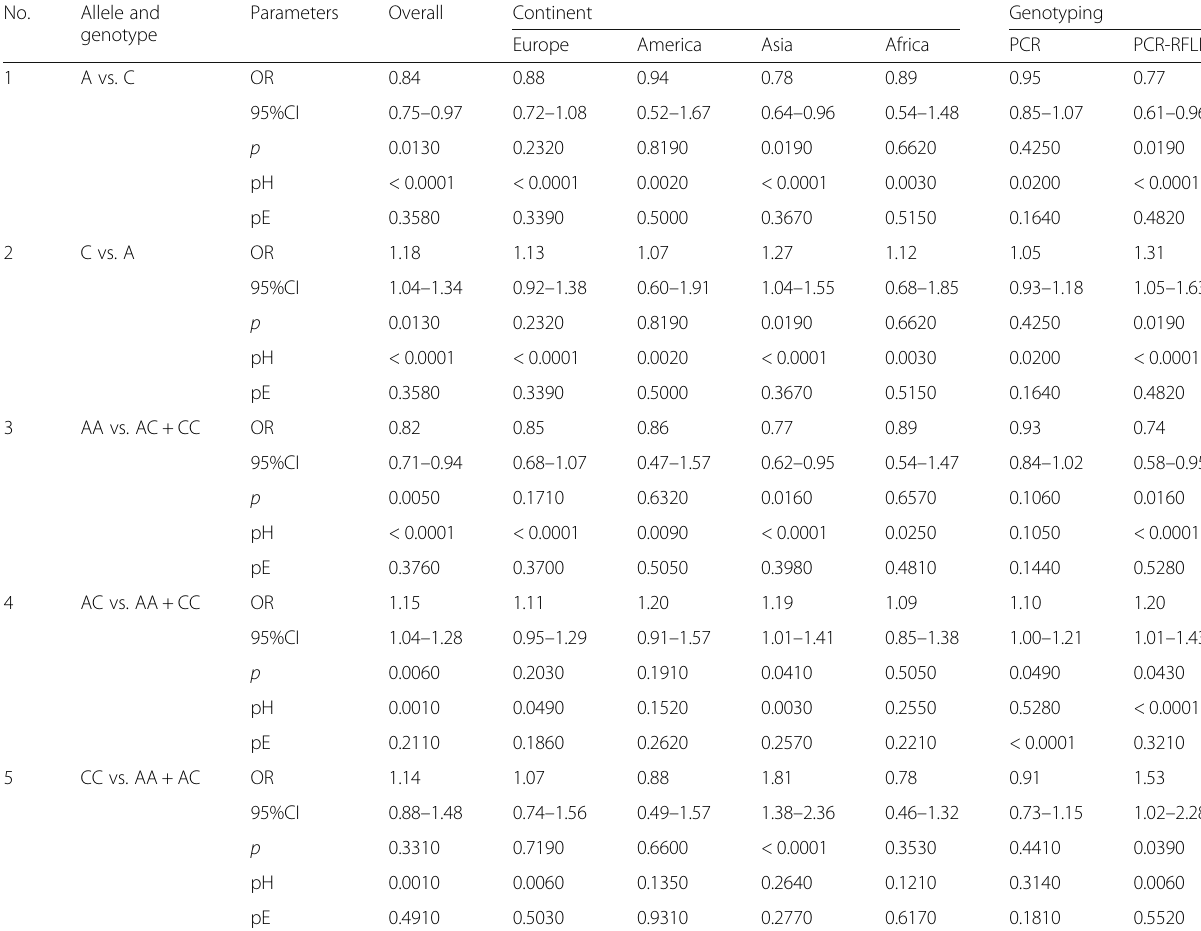
Table 2 Summary of analysis concerning the association between AT1R A1166C gene polymorphism and the risk of essential hypertension Allele and